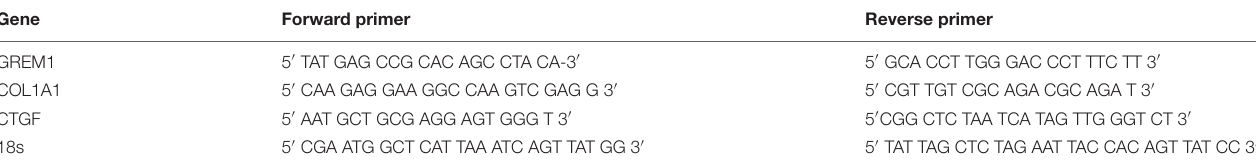
TABLE 1 | PCR primer sequences used in this